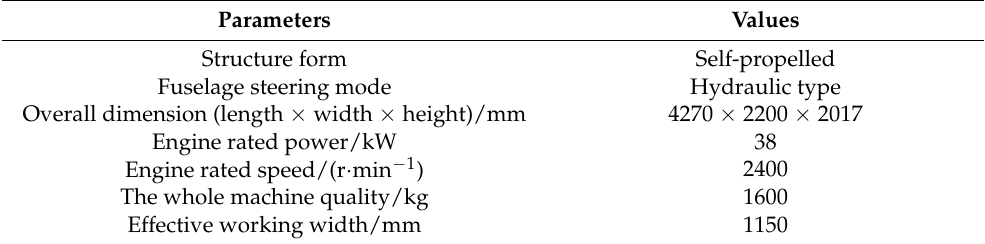
Figure 1. Mechanical floor-standing jujube picker structure diagram. 1. Profile wheel. 2. Comb teeth. 3. Hydraulic cylinder. 4. Pickup device. 5. Hydraulic track. 6. Rack. 7. Conveying and separating device. 8. Lift cylinder. 9. Turn over cylinder. 10. Fruit collecting device. 11. Axial flow fan. 12. Conveying combination rod. 13. Engine assembly. 14. Driving operating platform. 15. Strip brush. 16. Profile Table 1. Structural parameter table of mechanical landing red date pickup machine. Parameters